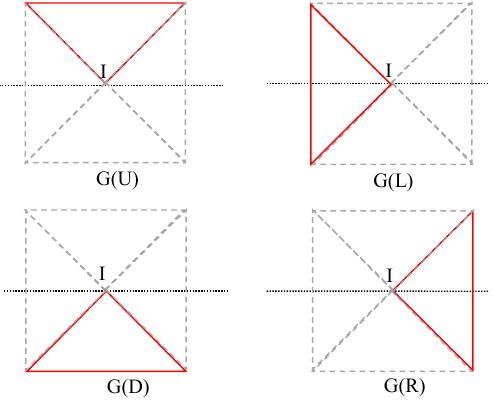
Figure 4. The four triangular Gaussian subtemplates.